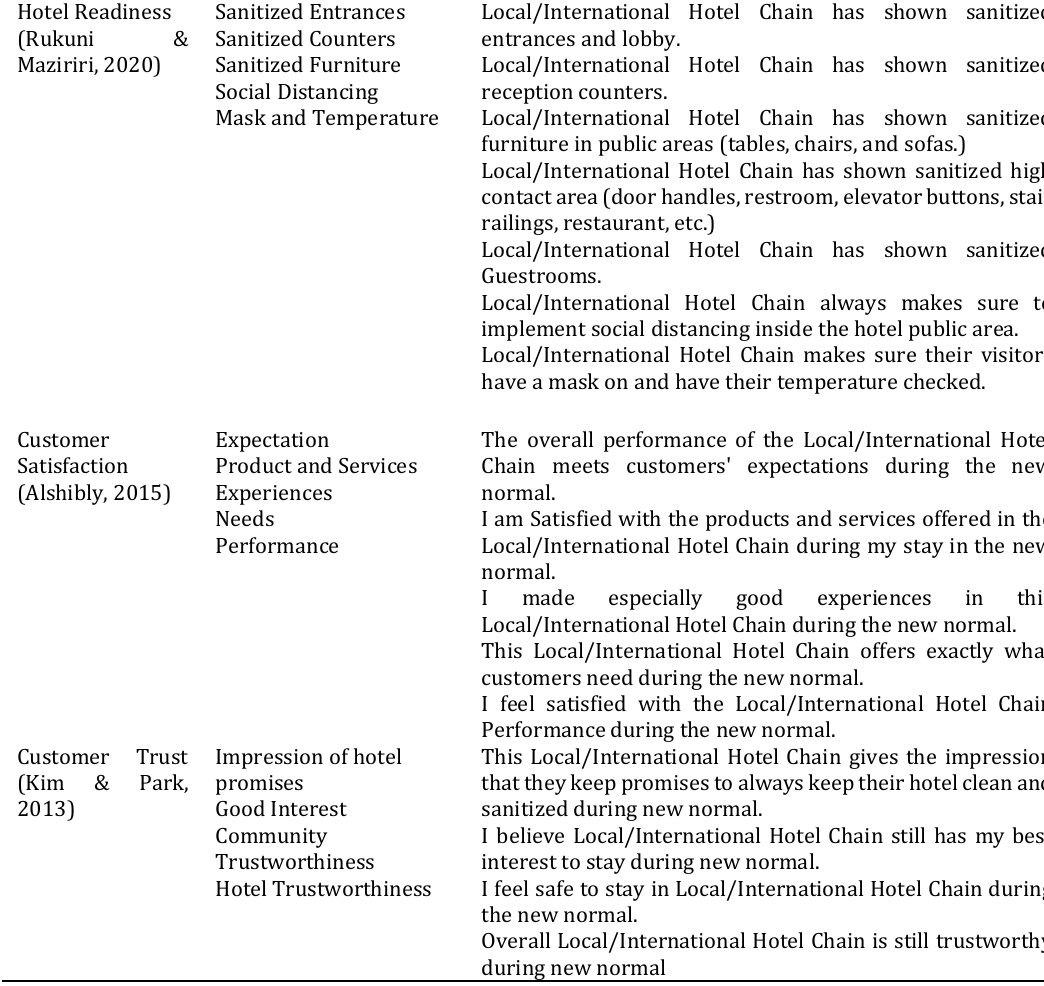
Table 1: Measurement table